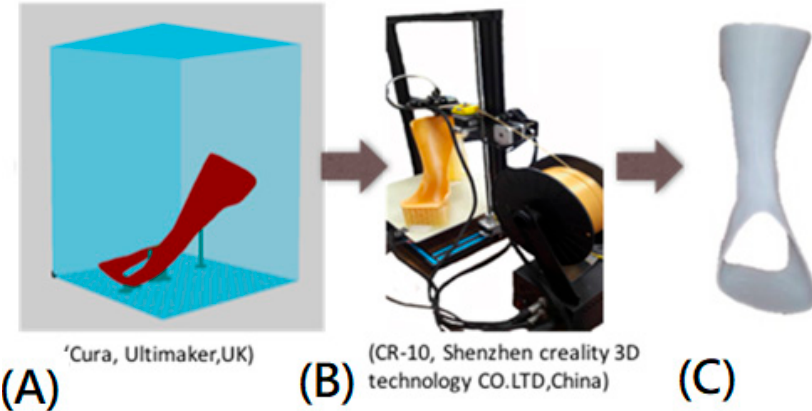
Figure 1. The 3D printing process: ( A ) Slicing the AAFO model. ( B ) Printing 3DP-AAFO in the CR 10 printer. ( C ) 3DP-AAFO after cleaning all